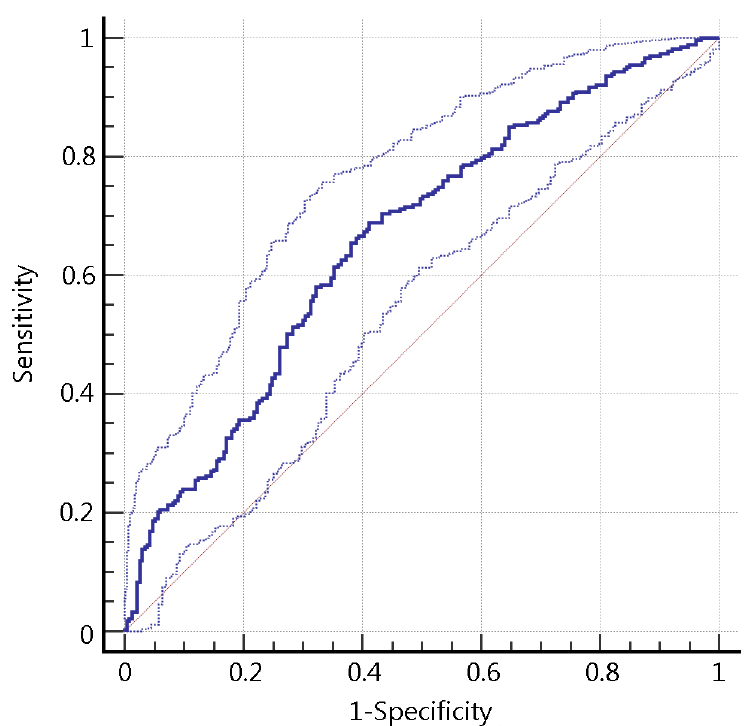
Figure 3. The ROC curve of the artificial neural network model, with 95% CI boundaries. ROC curve: Receiver operating characteristic curve; CI: Confidence interval.